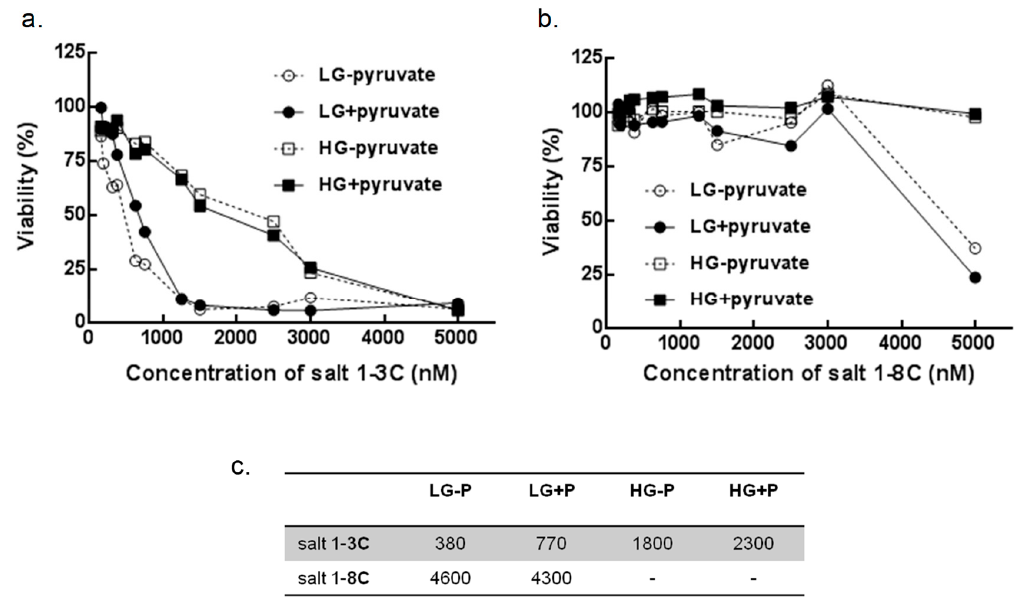
Figure 7. Viability depends on glucose and pyruvate availability. Resazurin viability assay for A-375 cells treated with salt 1- 3C ( a ) or salt1- 8C ( b ) at the indicated concentrations and cultured in Dulbecco’s modified Eagle’s medium (DMEM) with low (LG) or high (HG) glucose and with ( + P) or without ( − P) pyruvate for 72 h. ( c ) IC 50 (nM) determined from A . Each sample was measured in five replicates.